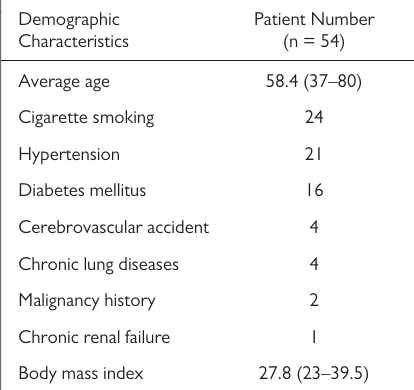
Table1. Demographic Characteristics of